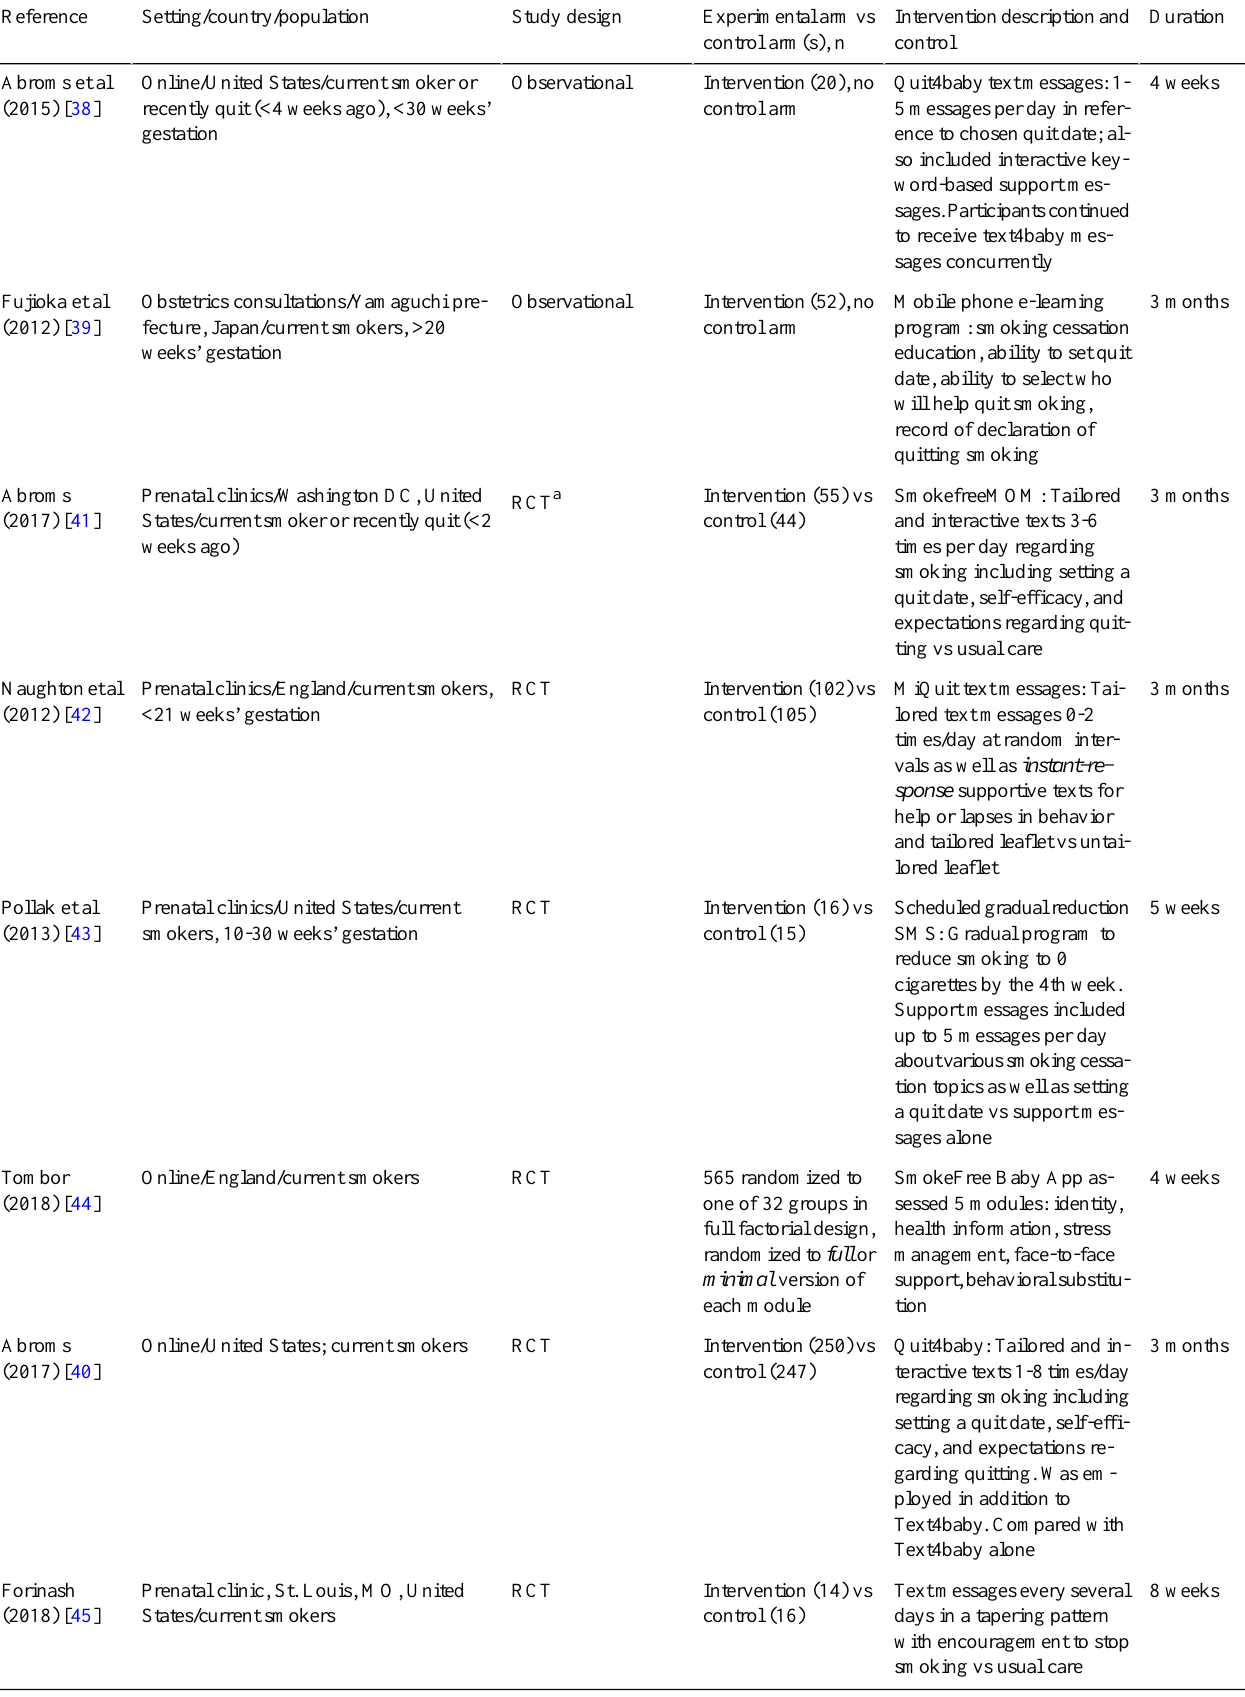
Table 3. Design of trials with a focus on smoking